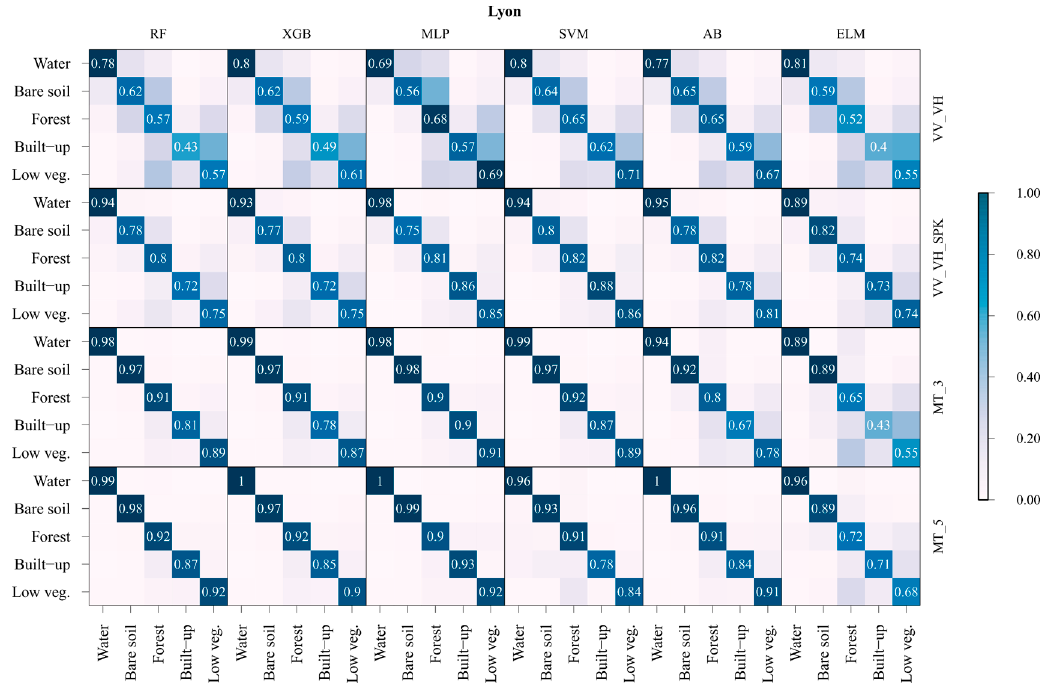
Figure 4. Visualization of normalized confusion matrix computed using various machine learning methods for single-date and multitemporal classification scenarios. Table 4. The mean values of user’s accuracy (UA) and producer’s accuracy (PA) of individual land- cover (LC) classes in different classification scenarios using S1 imagery (the best UA and PA values for scenario are highlighted in bold).